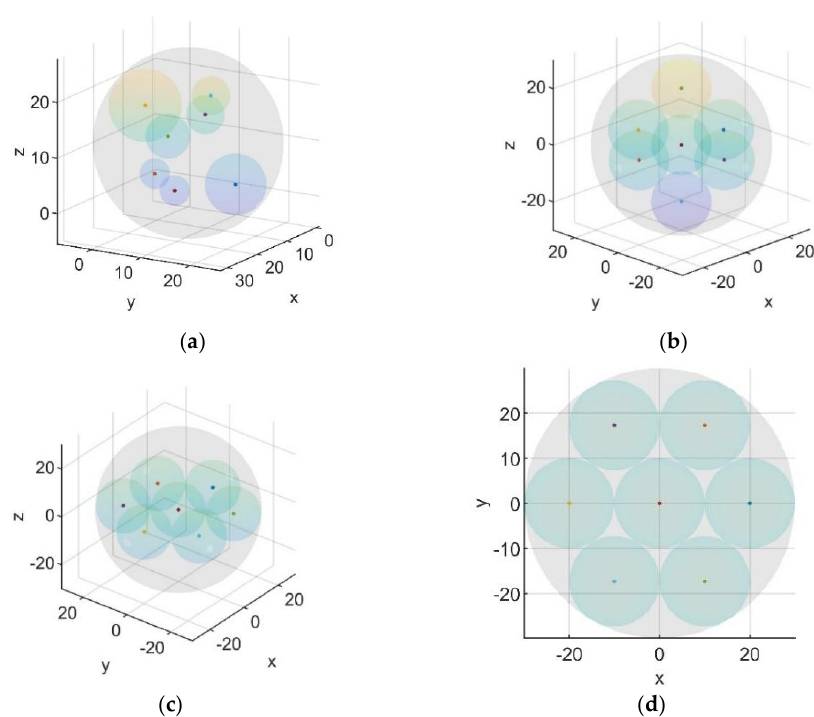
Figure 4. The monopolized sphere of each member satellite in the satellite cluster. ( a ) The monopolized sphere of each member satellite when the satellite cluster is randomly distributed; ( b ) The monopolized sphere of each member satellite when the satellite cluster is evenly distributed in three dimensions; ( c ) The monopolized sphere of each member satellite when the satellite cluster is evenly distributed in two dimensions ( - - x y z plane); ( d ) The monopolized sphere of each member satellite when the satellite cluster is evenly distributed in three dimensions ( - x y plane).